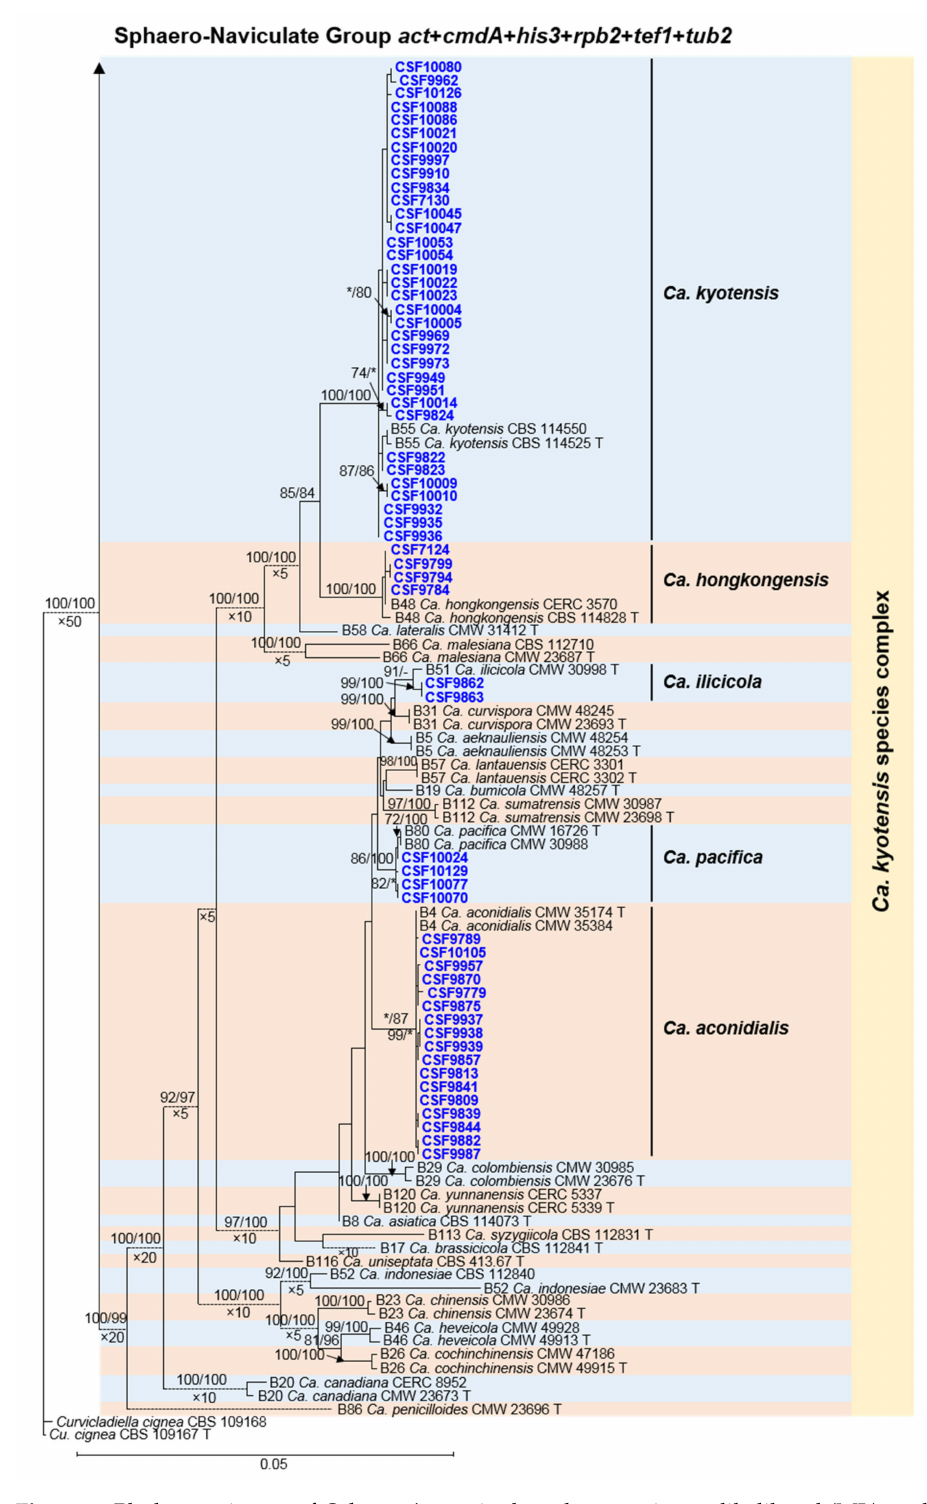
Figure 3. Phylogenetic tree of Calonectria species based on maximum likelihood (ML) analyses of combined DNA dataset of act , cmdA , his3 , rpb2 , tef1 , and tub2 gene sequences. Bootstrap value ≥ 70% for ML and MP analyses are presented above the branches. Bootstrap values lower than 70% are marked with “*”, and absent analyses values are marked with “-”. Ex-type isolates are marked with “T”. Isolates sequenced in this study are highlighted in blue and bold type. The “B” species codes are consistent with the recently published results in Liu and co-authors [18]. The tree was rooted to Curvicladiella cignea (CBS 109167 and CBS